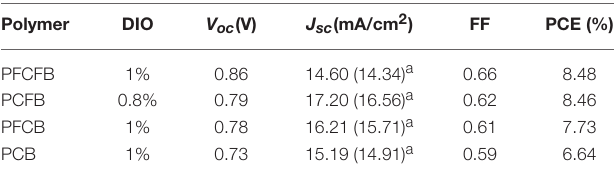
TABLE 2 | Photovoltaic parameters of devices based on PFCFC, PCFB, PFCB, and PCB .